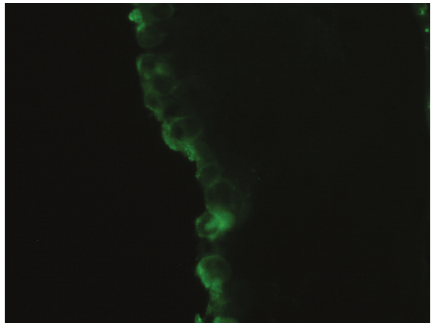
Figure 5: C3 deposition along the basement membrane.